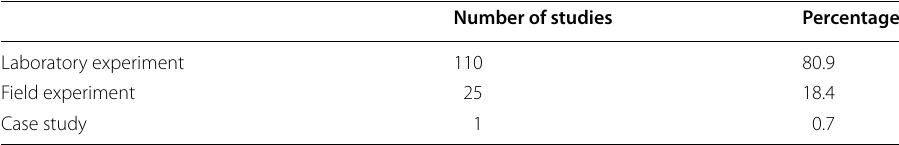
Table 6 Distribution of research methodologies